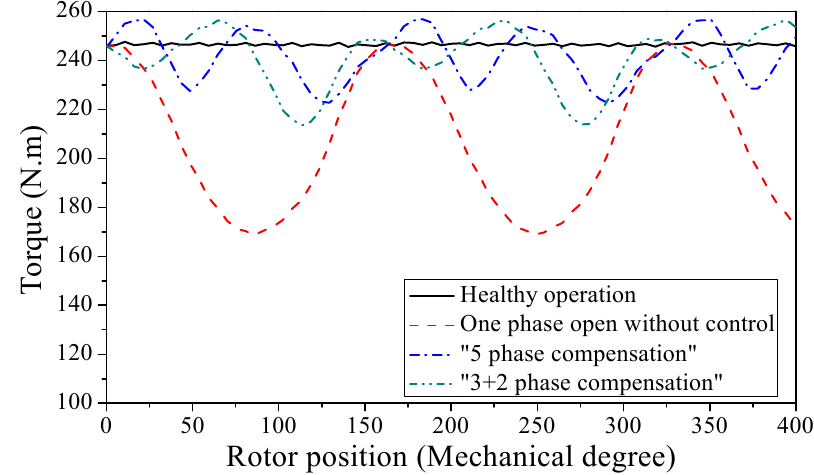
Figure 12. Torque behavior for one-phase-open fault.